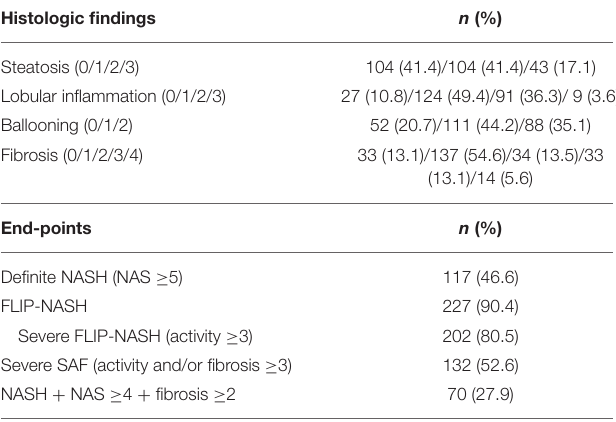
TABLE 1 | Patients’ baseline characteristics ( n = 251). TABLE 2 | Histologic findings ( n =